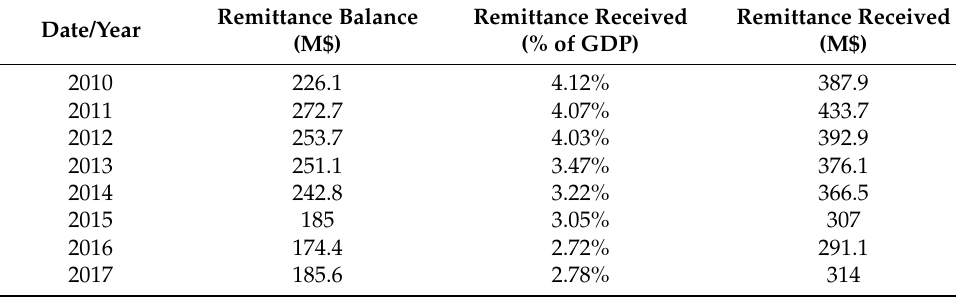
Table A2. Remittances received by Macedonia (Annual